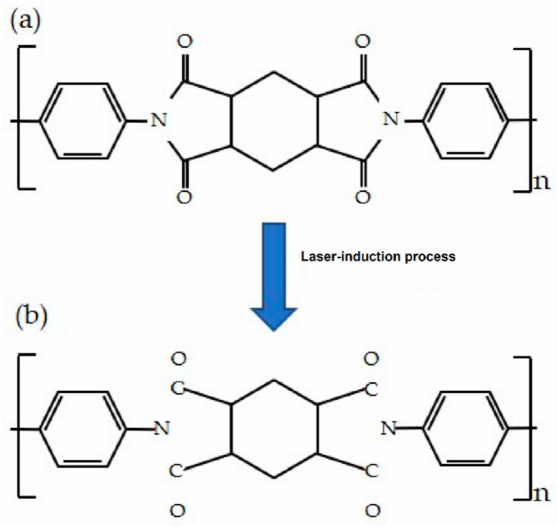
Figure 2. Principle of the formation of laser-induced graphene. Structure of polyimide film ( a ) before and ( b ) after the laser irradiation process [85]. Copyright 2019